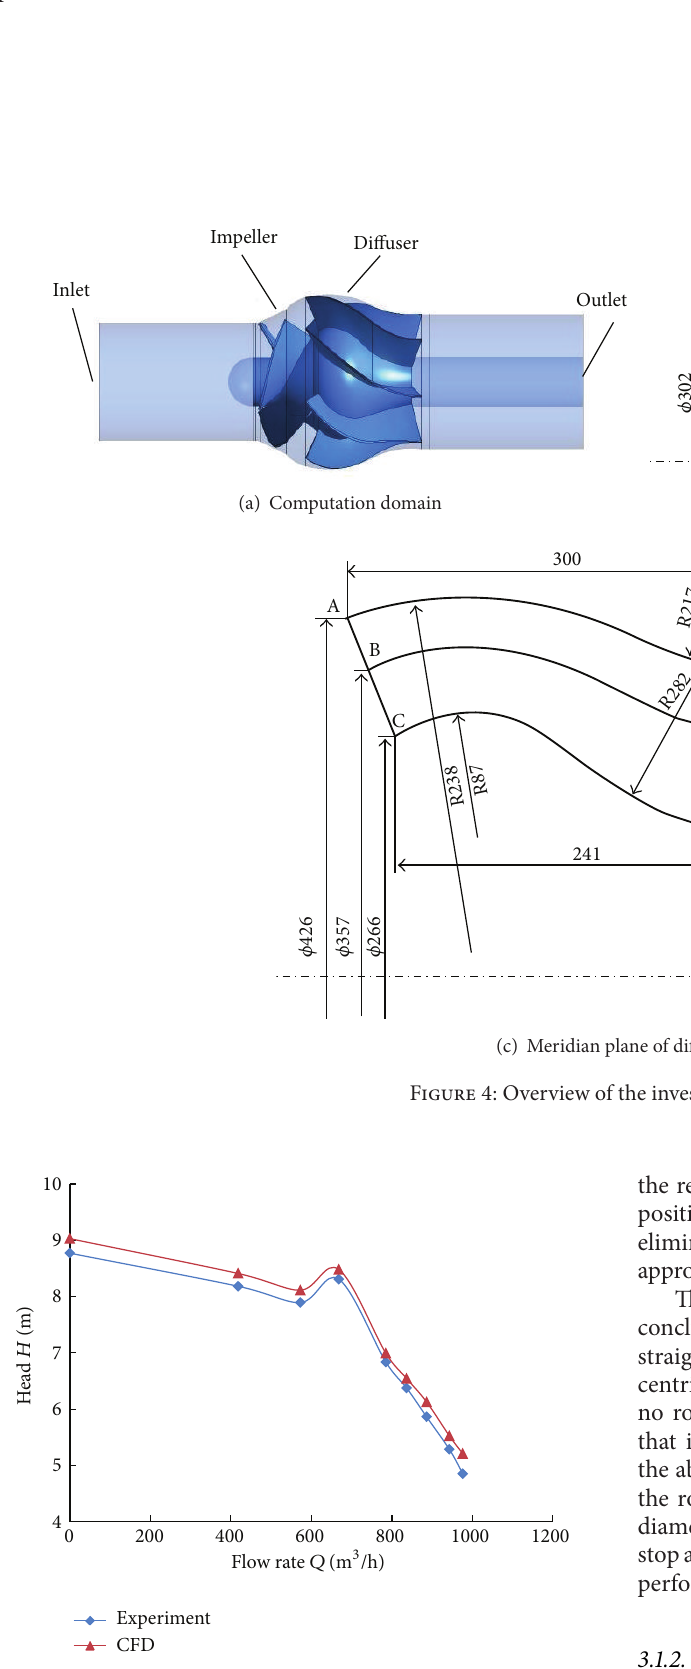
Figure 5: Measured and calculated head (total pressure)